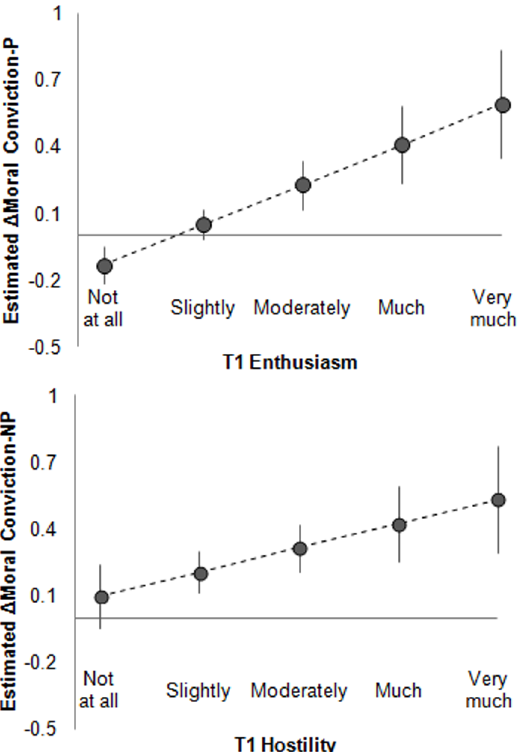
Figure 3. Estimated change in moral conviction at levels of time 1 enthusiasm and hostility. Note. Error bars are 95% confidence intervals of the estimated change. All estimates based on the model reported in Figure 2 and Table S3 in the Supplemental